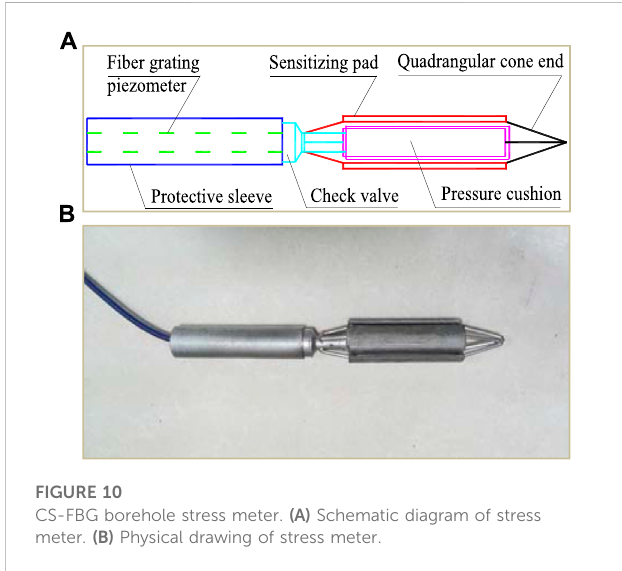
FIGURE 10 CS-FBG borehole stress meter. (A) Schematic diagram of stress meter. (B) Physical drawing of stress meter.